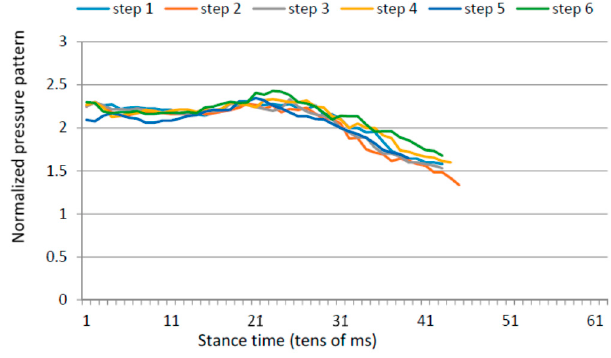
Figure 14. Anterior/posterior centre of pressure in the first six steps for a healthy control.